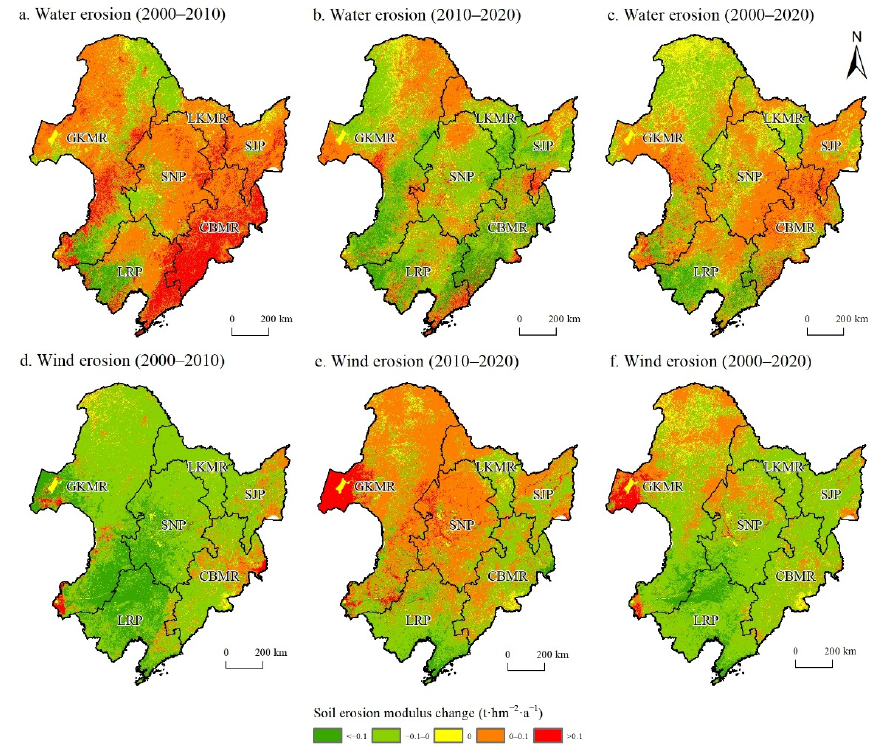
Figure 3. Distribution of interannual change trend of soil erosion modulus in Northeast China from 2000 to 2020, displayed in different timespans.